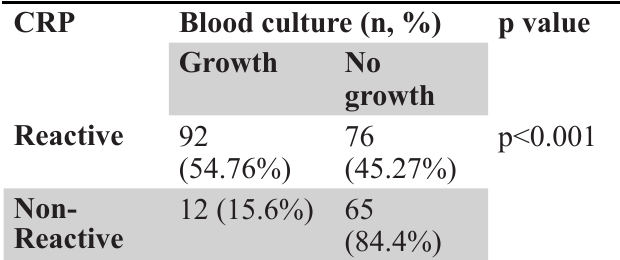
Table 3. Association between CRP and blood cul- ture status